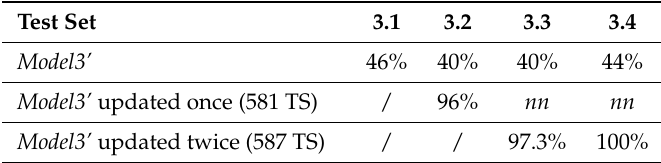
Table 5. Classification accuracies of Model3’ after the retraining process.